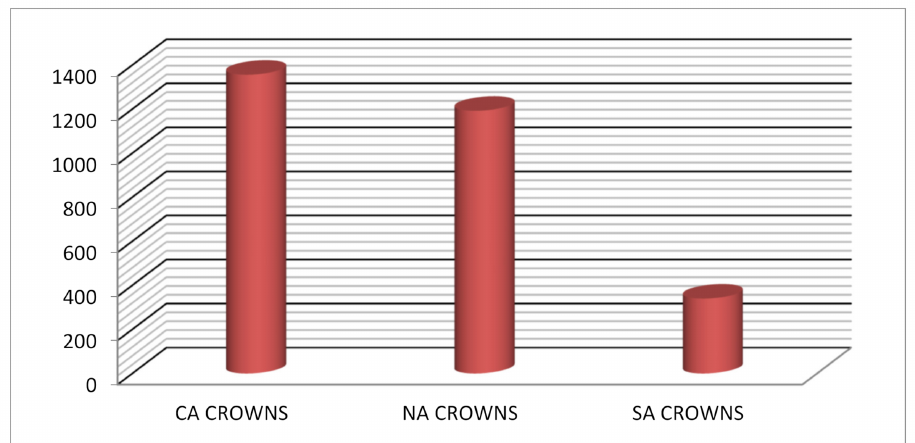
Figure 1. Shows mean load observed at anterior region among different types of crowns.